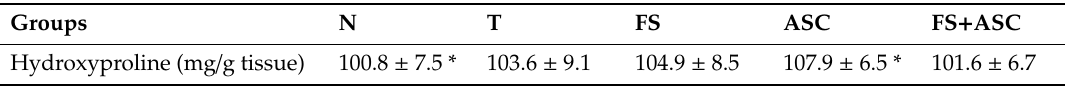
Table 1. Hydroxyproline concentration (mg/g tissue) in the entire tendon (n = 8). (*) Significant difference between N and ASC